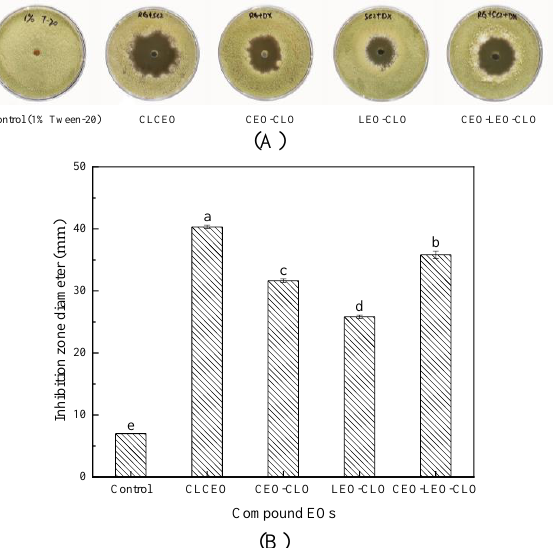
Figure 4. Antifungal effect of four combined EOs on strain YQM (CLCEO: cinnamon-litsea combined EO): ( A ) growth of strain YQM on 9-cm plate media; ( B ) quantification of inhibition as zone diameter. Values are average values ± standard deviation (biological replicates, n = 3). Values with different superscript lowercase letters show significant differences among treatments ( p < 0.05).